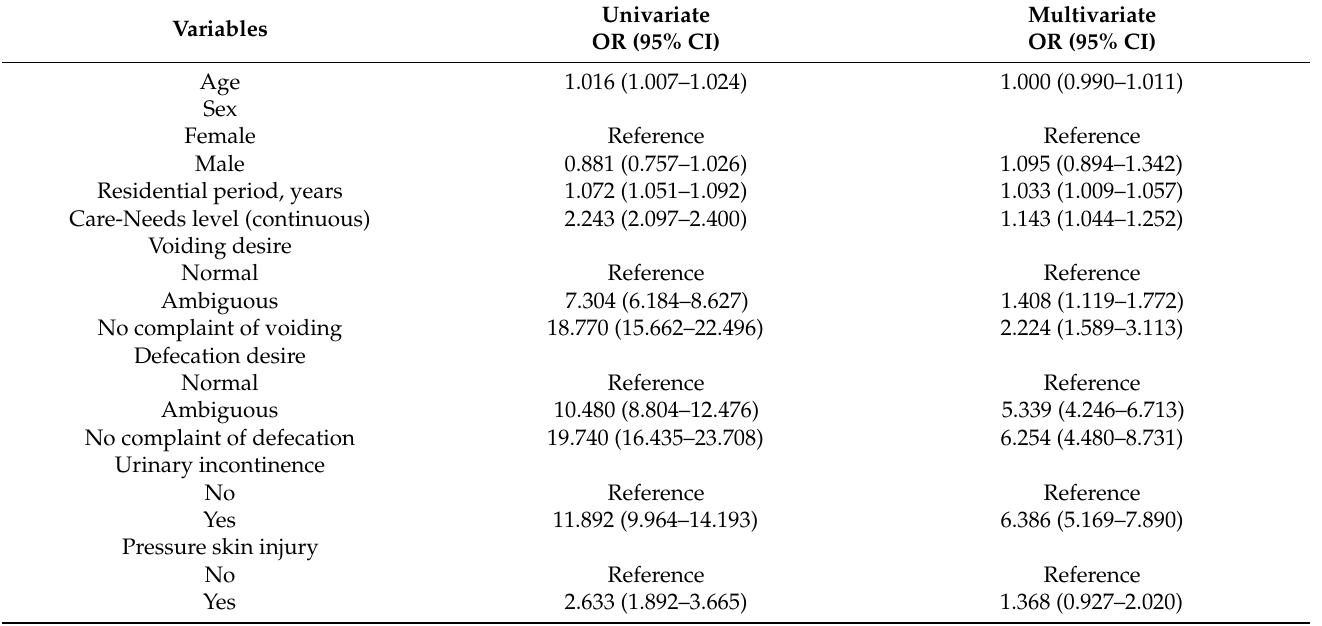
Table 3. Risk factors of fecal